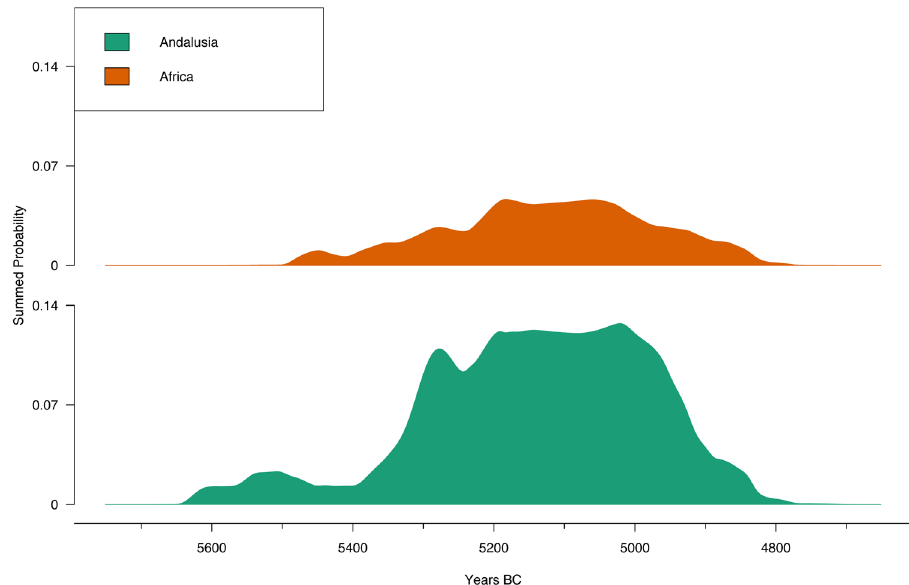
Figure 3: Summed probability distribution of Andalusia ( lower graph ) and Northern Morocco ( upper graph ) . Rcarbon v.1.4 ( Crema & Bevan, 2021 )